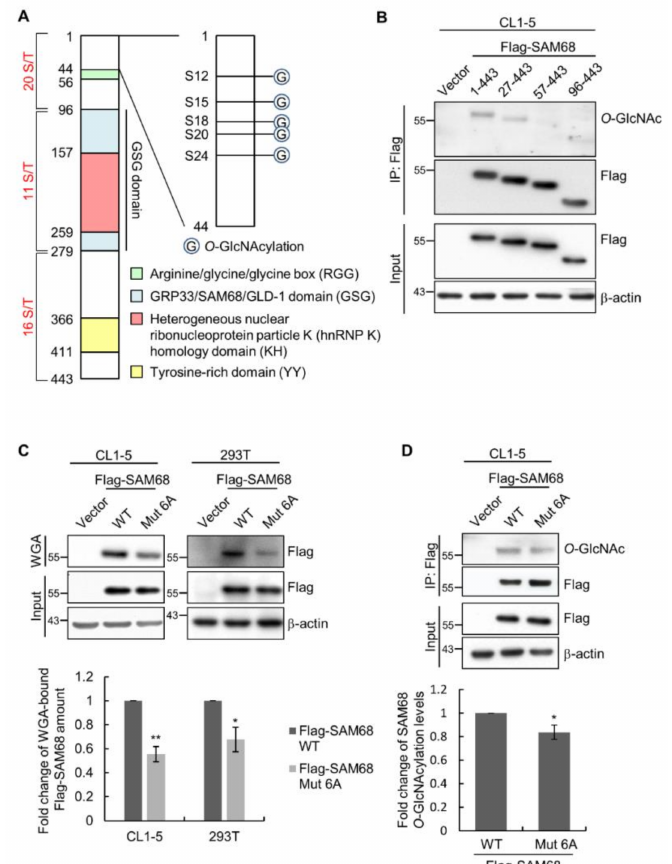
Figure 4. Characterization of SAM68 O -GlcNAcylation by truncation analysis and